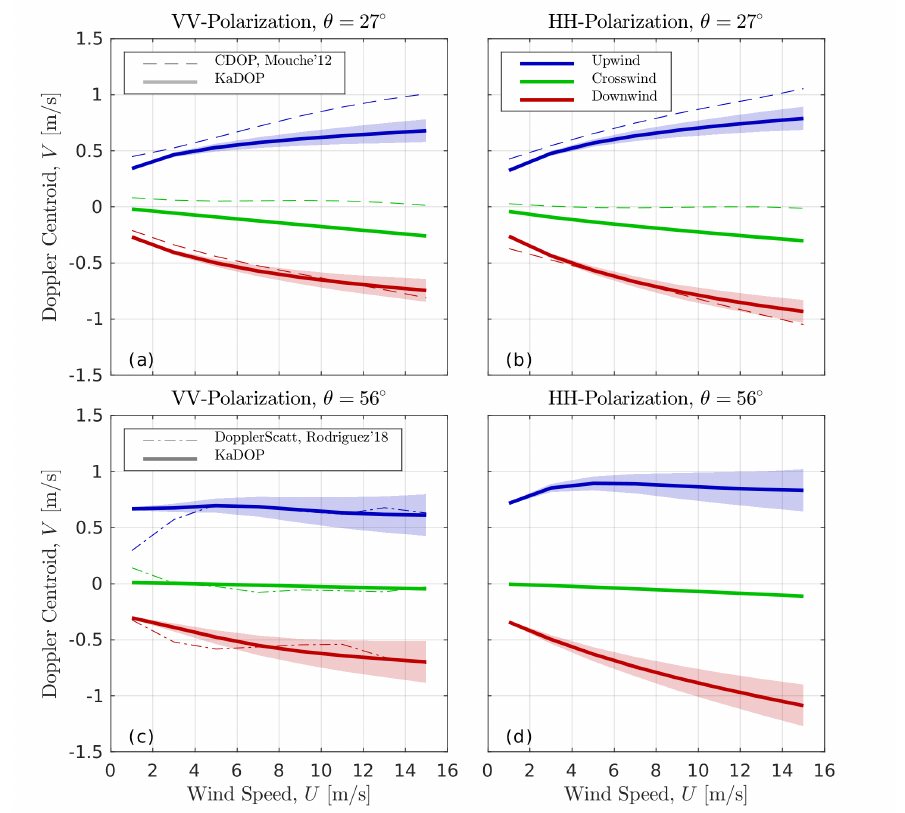
Figure 10. Doppler centroid versus wind speed for ( a , b ) θ = 27 ◦ and ( c , d ) θ = 56 ◦ . ( a , c ) VV-polarization, ( b , d ) HH-polarization. Confidence interval corresponds to wind drift variations between 0 and 3% U